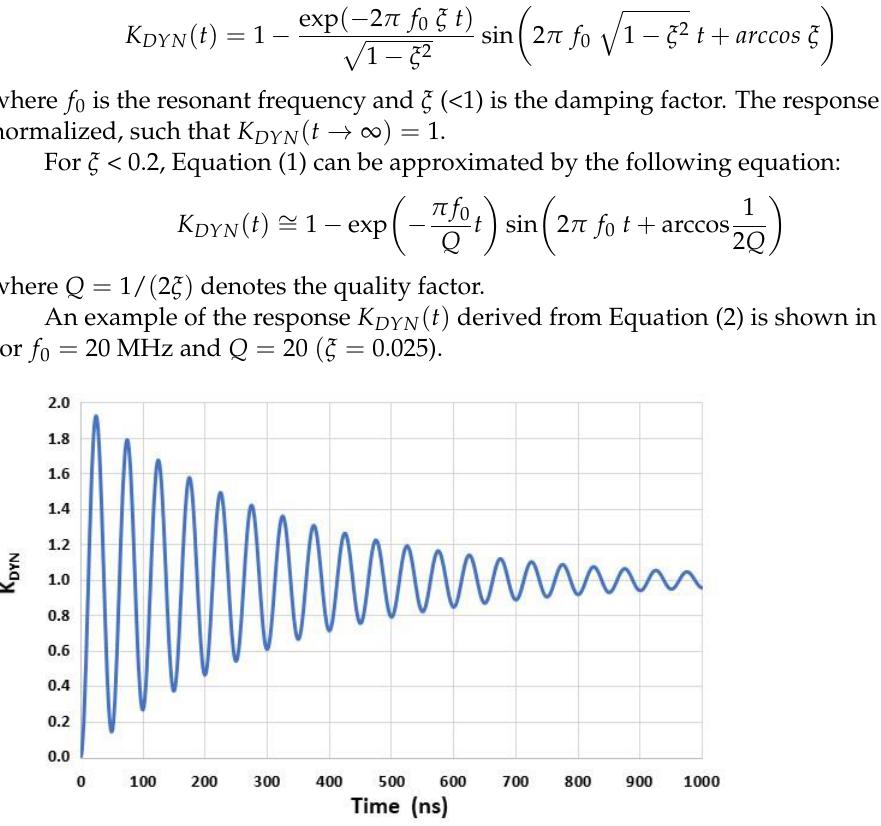
Figure 4. Example of a simulated second-order time-domain response ( 𝐾 𝐷𝑌𝑁 (𝑡) ) of a sensor sub- jected to a pressure step for 𝑓 0 = 20 𝑀𝐻𝑧 and 𝑄 = 20 (𝜉 = 0.025 ). to a pressure step for f = 20 MHz and Q = 20 ( ξ = 0.025 ) 0